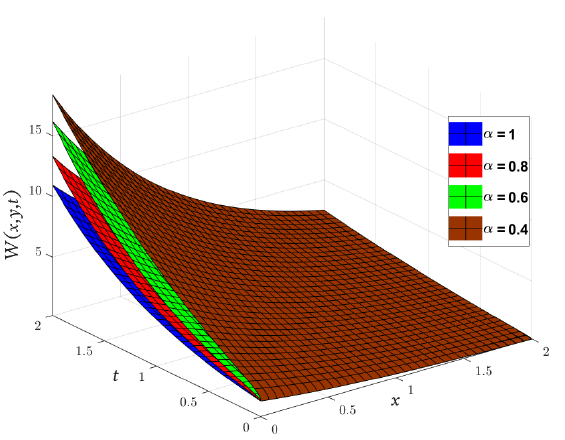
Figure 8. Three-dimensional plots of the approximate and exact solutions of W ( x , y , t ) (Example 3) using the LADM.